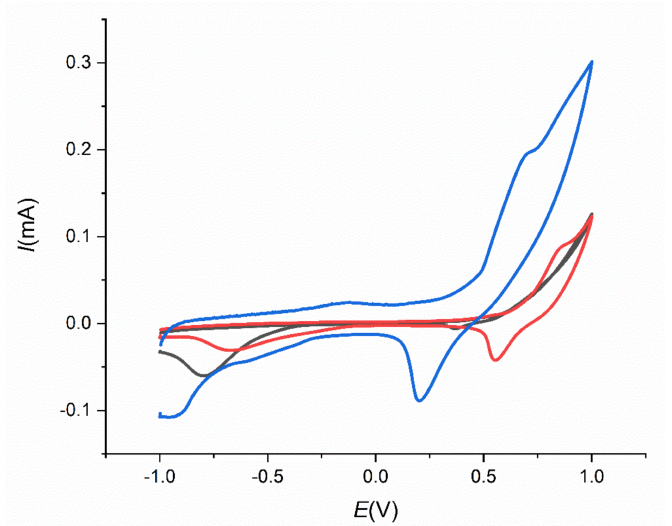
Figure 14. Cyclic voltammograms for 10 µ M insulin in 0.1 M NaOH on SPCE/MWCNT/NiO1.5 stored for 72 h at 8 ◦ C (blue line), 22 ◦ C (red line), and 40 ◦ C (black